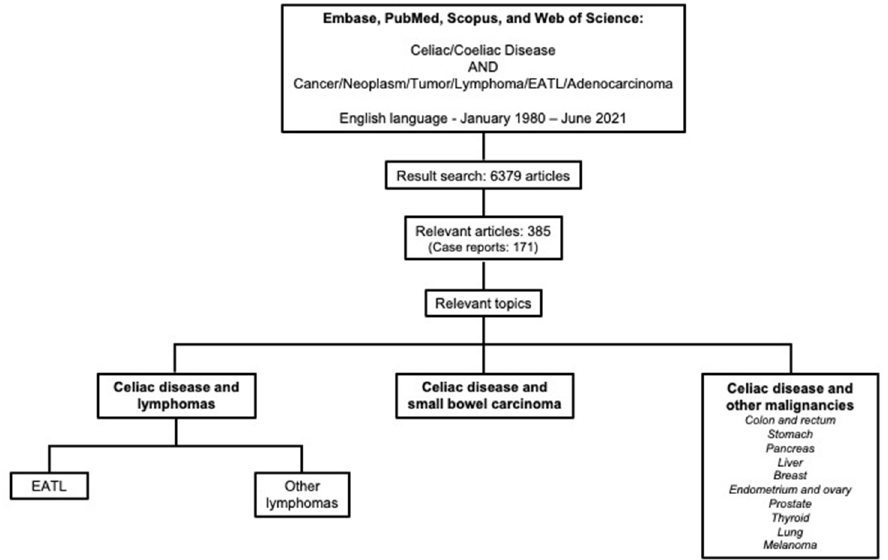
Figure 1. Literature search.